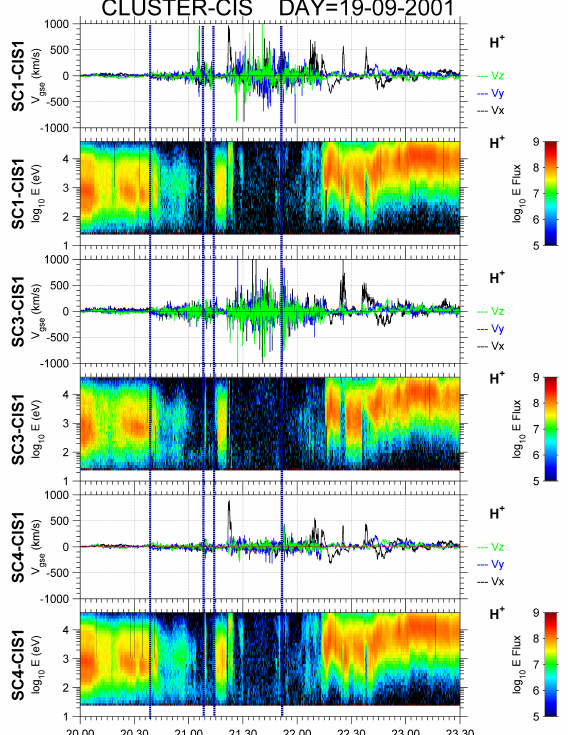
Fig. 13. H + ion velocities (GSE components) and energy flux-time spectrograms, measured by the CIS1/CODIF instruments on s/c 1, 3, and 4. Vertical dashed lines mark the substorm onset and intensi- fications as determined from the ground-based magnetic field data. Energy fluxes are integrated over 4 π steradians and the time reso- lution is 8s. Moments have been derived with a 4-s resolution. In the lobes, where the ion density is lower than ∼ 0.05cm − 3 , velocity components are meaningless.